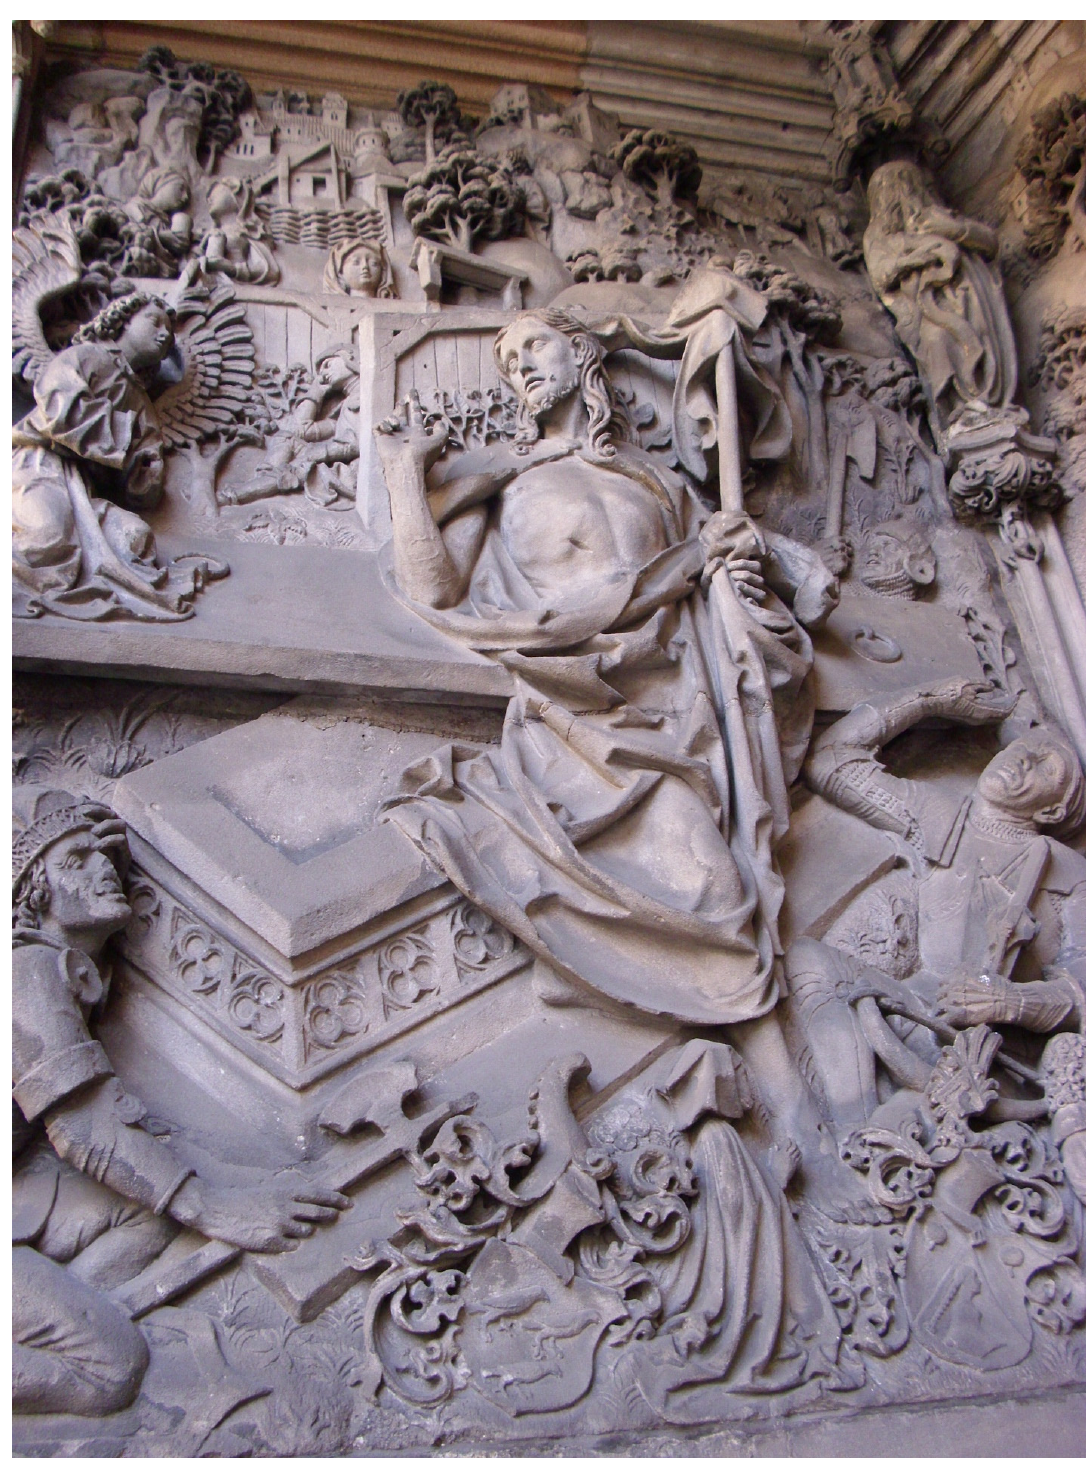
Figure 5. Kraft, Schreyer–Landau Epitaph, Detail: Resurrection. Earlier Passion scenes begin at the far right with Christ Carrying the Cross (Figure 6), fallen to his knees while surrounded by mockers. The sympathetic holy figures, led by the Virgin, remain confined to a distant rise in the upper left.